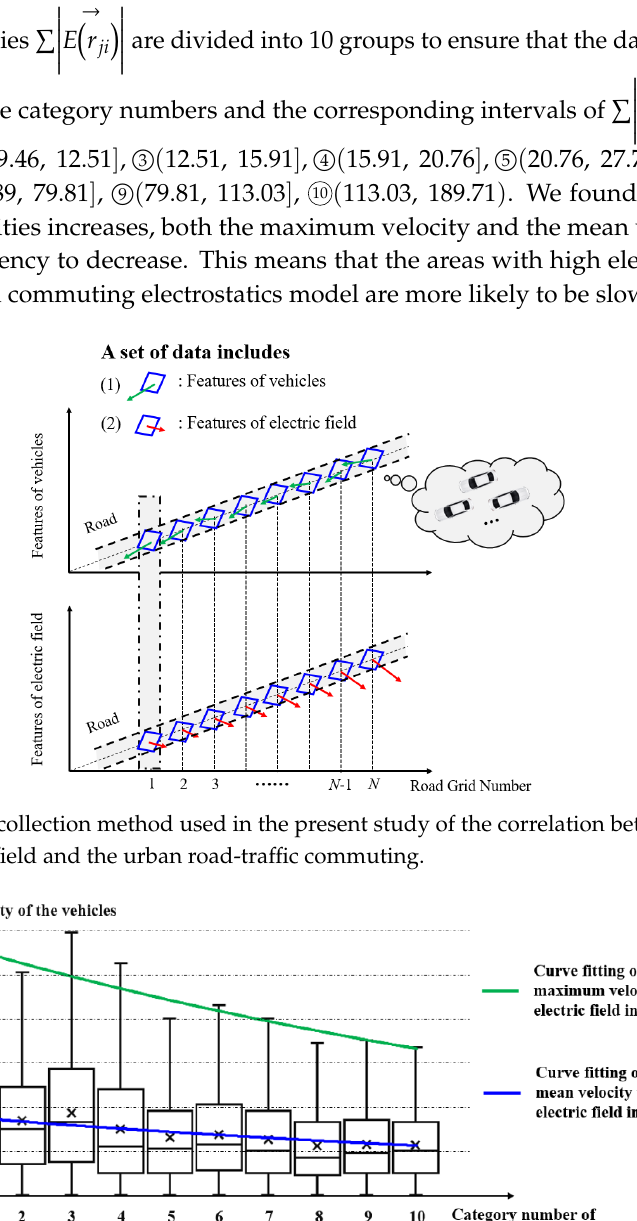
(cid:80)(cid:12) (cid:12) (cid:12) . Figure 12. Correlation between the maximum velocity / mean velocity of the vehicles and (cid:12) (cid:12) (cid:12)